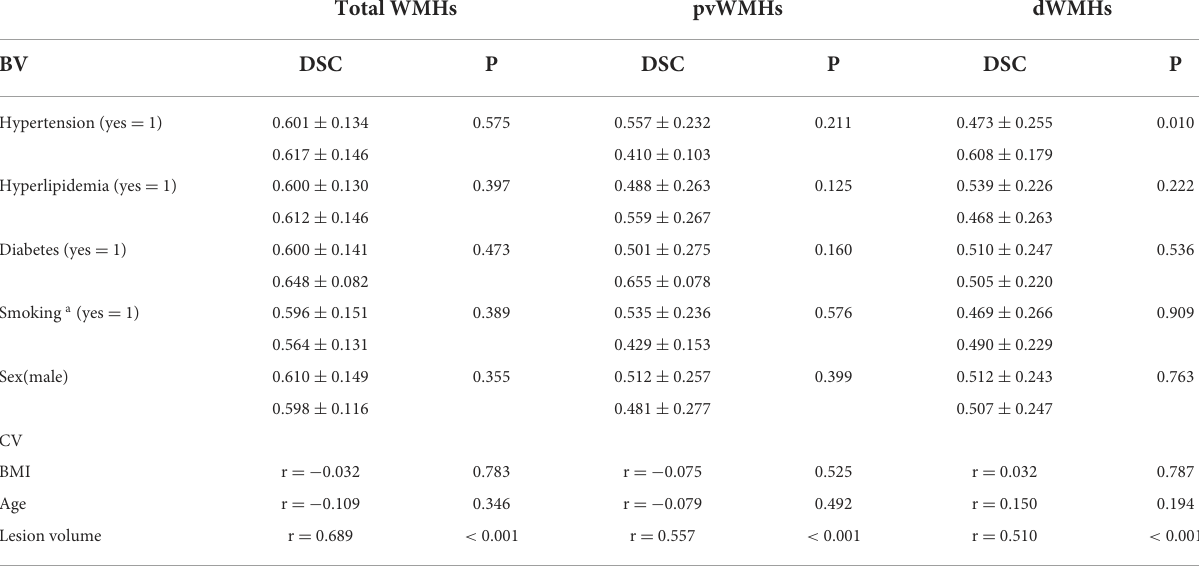
TABLE 5 Association between demographic, clinical factors, and the segmentation results of Cascade U on testing